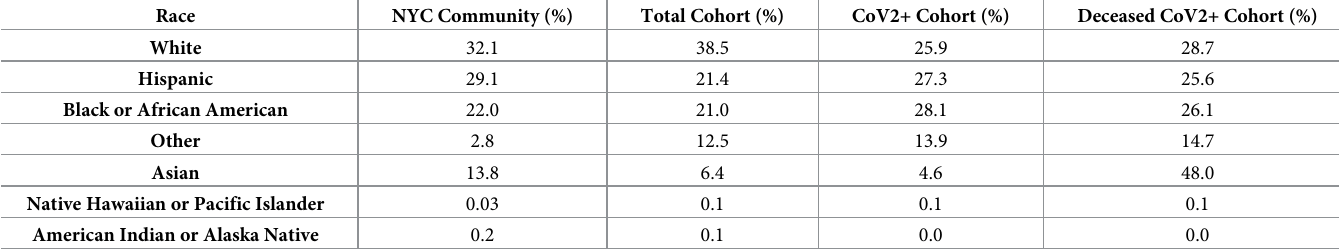
Table 1. Diversity of Mount Sinai Health System COVID-19 patient